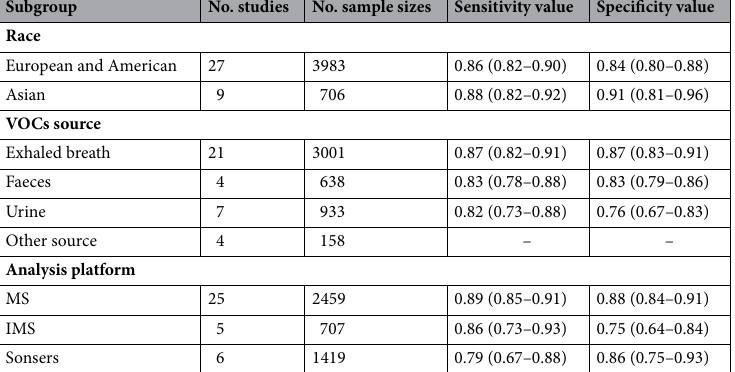
Table 2. Subgroup analysis of diagnostic effect. Data selection in subgroup analysis of race group: Samples in three studies were from the same race group. My data extraction: Kumar S 2015 selected gastric